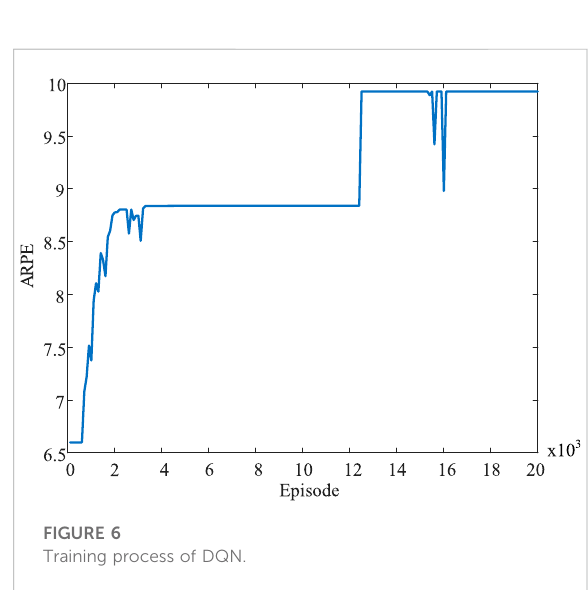
FIGURE 6 Training process of